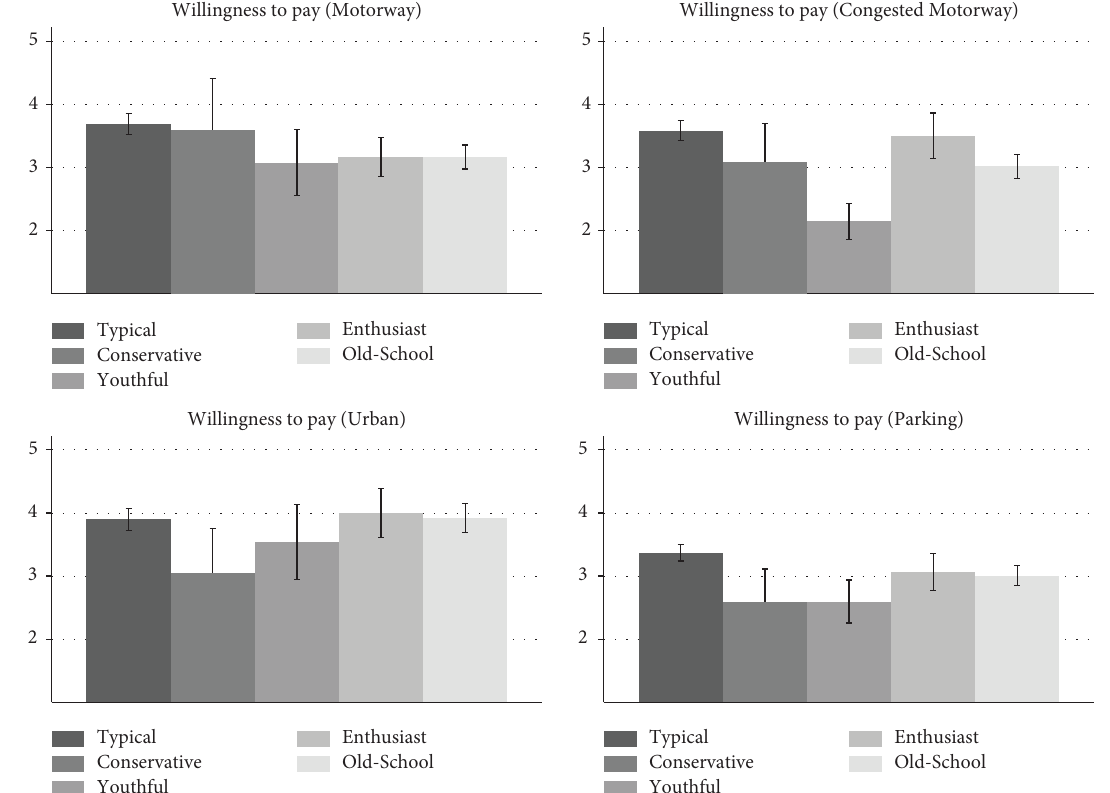
Figure 7: Willingness to pay for CAC for each automated driving function. Tin vertical lines represent the 95% confdence interval.